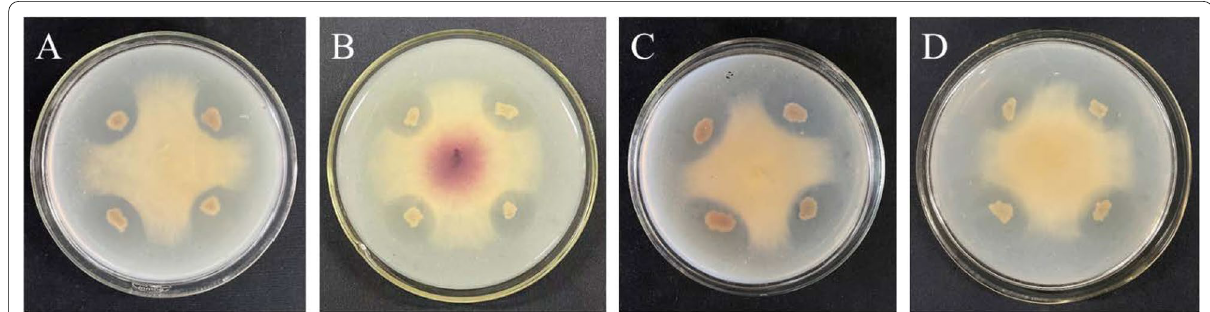
Fig. 3 Antifungal activity of Bacillus amyloliquefaciens WS-10 against different pathogenic fungi. Fusarium oxysporum ( A ), F. graminearum ( B ), F. oxysporum ( C ), and Colletotrichum capsica ( D )